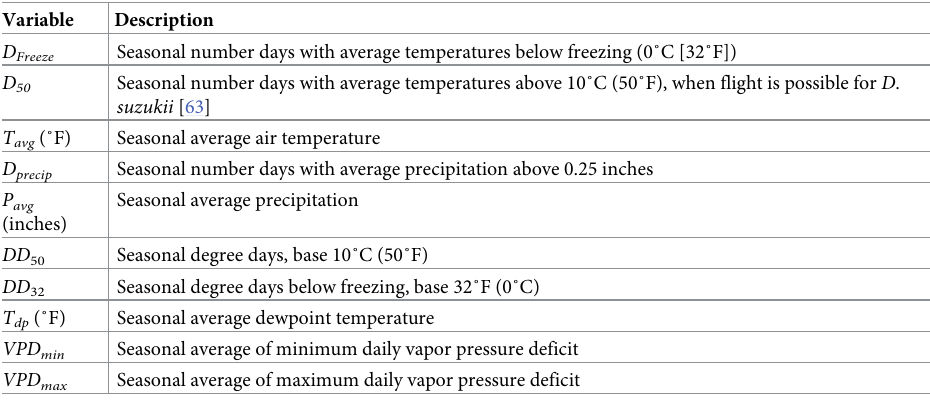
Table 1. Summary of seasonal climate variables extracted from station data for comparison with Rhagoletis men- dax and Drosophila suzukii annual first capture